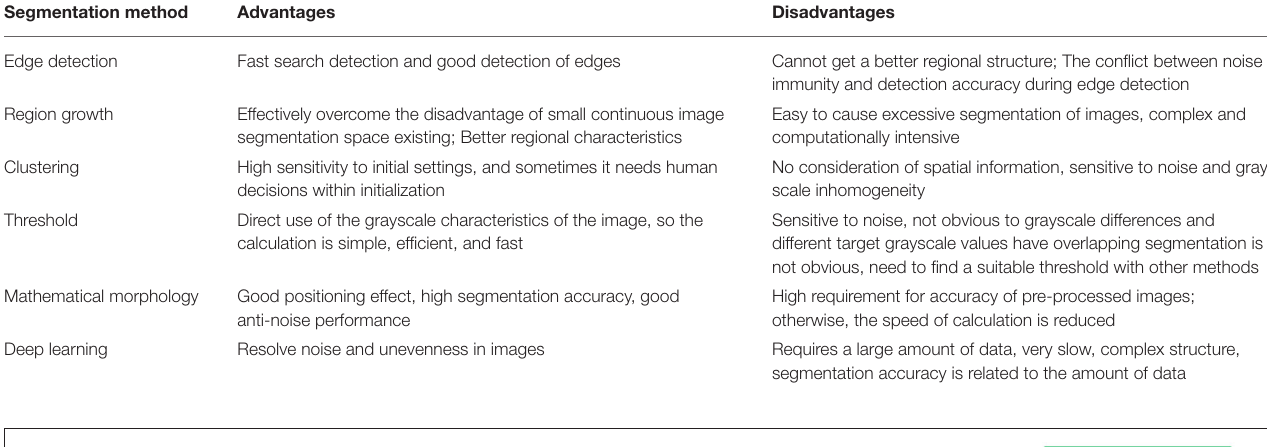
TABLE 1 | Existing segmentation methods and their advantages and disadvantages.